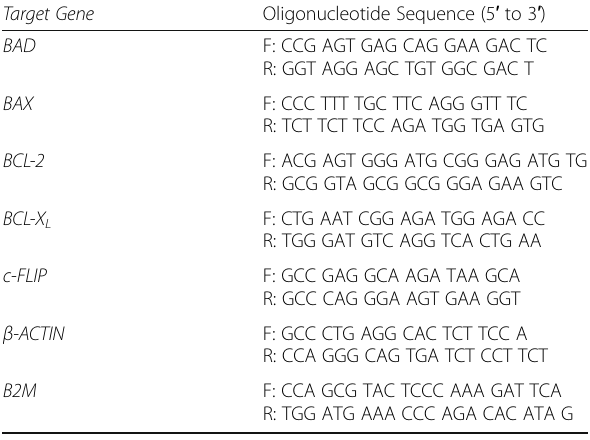
Table 1 Oligonucleotide sequences used for quantification of gene expression Target